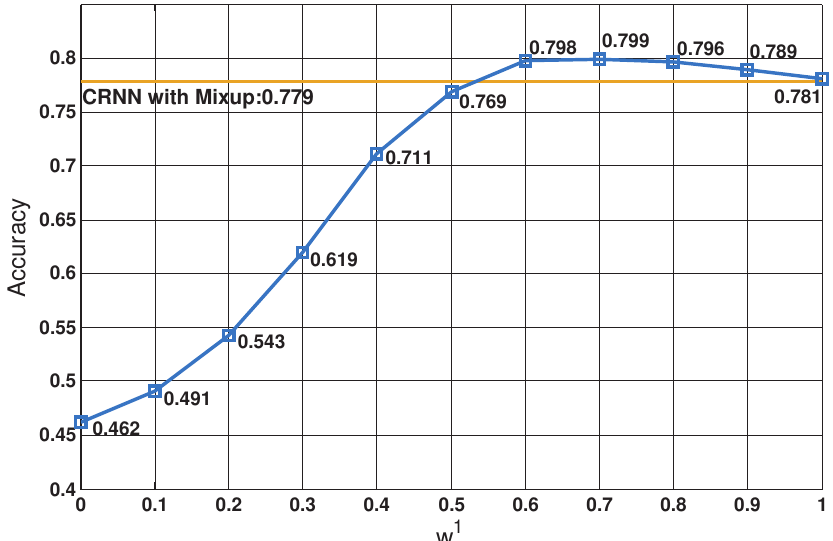
Figure 3. Classification accuracy with different weights. The blue line indicates the classification accuracy of different weights cases, while the orange line indicates the accuracy of CRNN with mixup system.